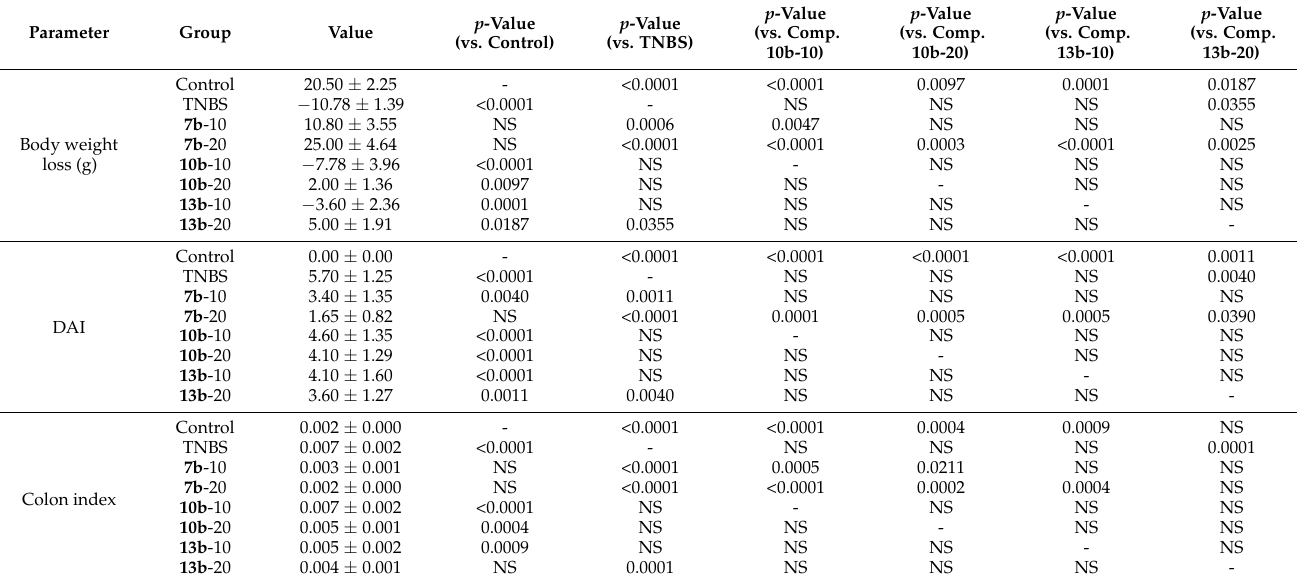
Table 1. The impact of compounds 7b , 10b , and 13b on the body weight loss, DAI, and colon index in experimental